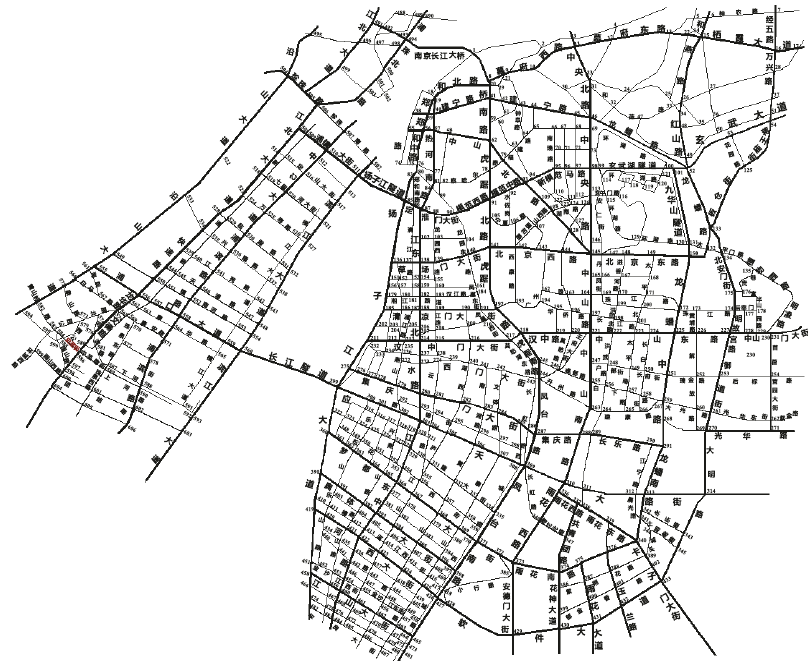
Figure 2: Topology of Nanjing’s traffic network.